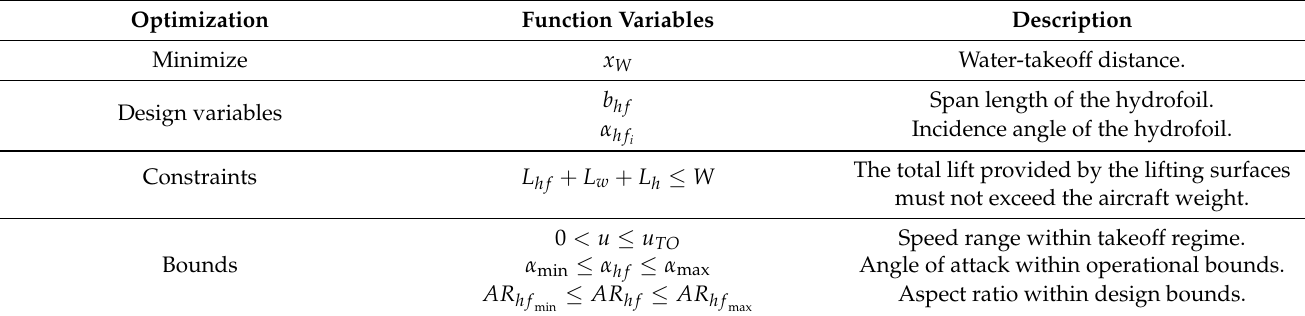
Table 1. Optimization problem formulation for the optimal hydrofoil span and incidence angle. Optimization Function Variables Description Minimize x W Water-takeoff distance. b hf Design variables